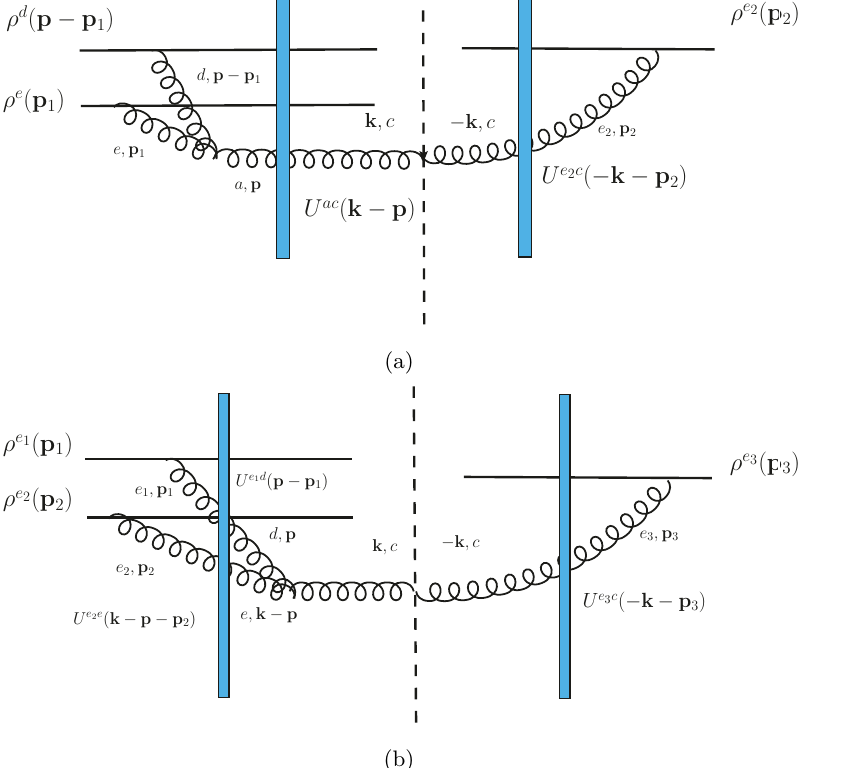
that contain two and three Wilson lines: (a) M (3) (1)